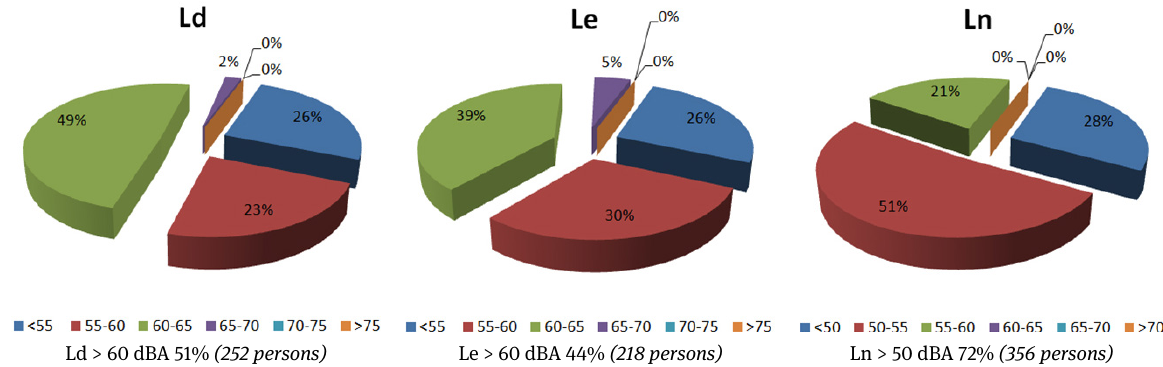
Figure 4: Population exposed to environmental noise ranges as derived from 2016 Granada SNM results, with an indication of people over AQO as in Table 1